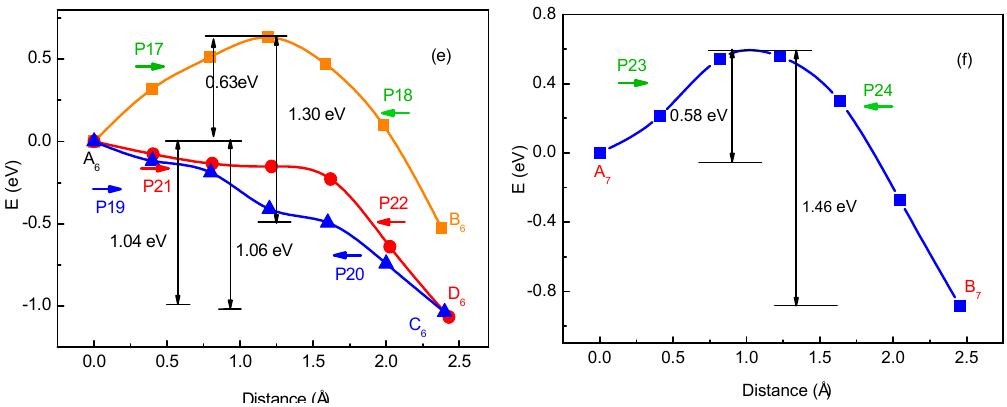
Figure 4. Total energy curves along Li + ’s migration pathways labeled as P1–P24 for three-Li + and four-Li + adsorbed systems with Li + arrangements shown in Figure 3b–g.